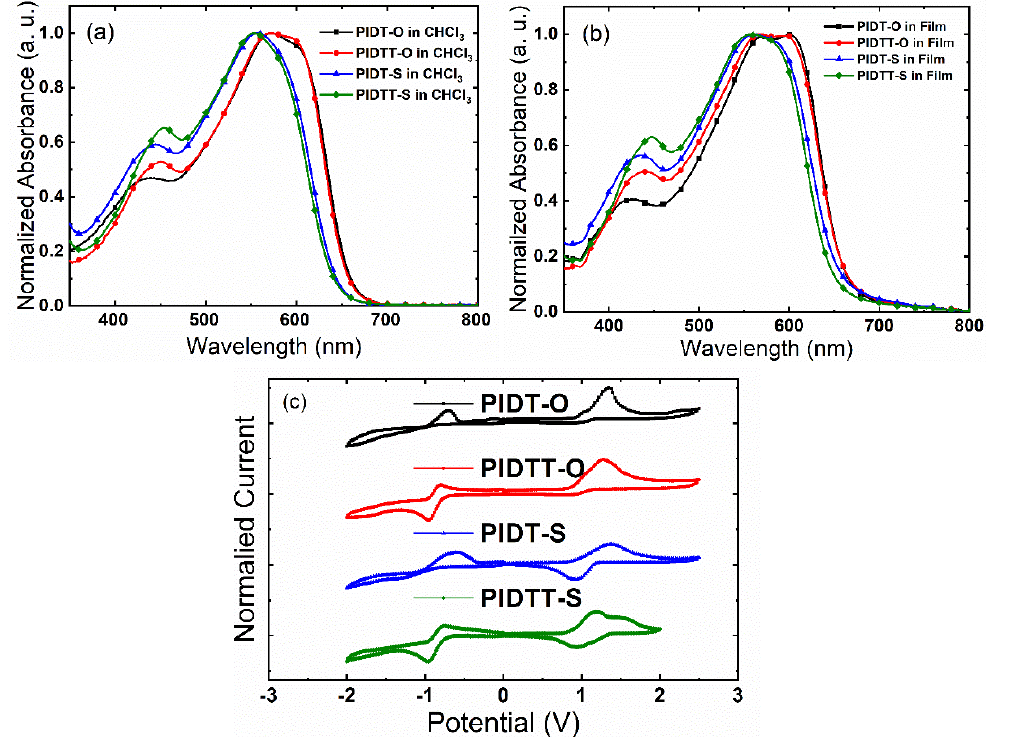
Figure 2. ( a ) UV-visible spectra in chloroform and ( b ) in film, ( c ) Cyclic voltammograms curves of PIDT-O, PIDTT-O, PIDT-S and PIDTT-S. Table 2. Optical and electrochemical properties of PIDT-O, PIDTT-O, PIDT-S and PIDTT-S. Polymers